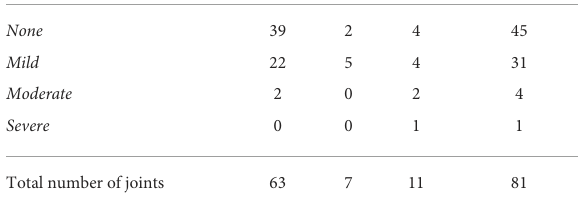
TABLE 1 Number, location and size of PIPJ JOC for horses in the case group.